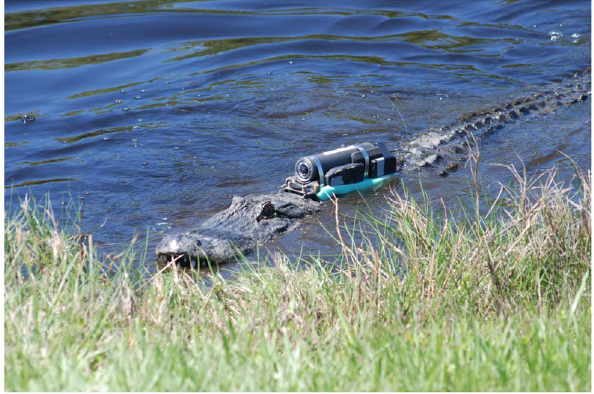
Figure 2. Crittercam unit attached to American alligator. Photograph of a 2.6 meter male American alligator ( Alligator mississippiensis ) with Crittercam unit attached. Reprinted with permis- sion from J.C.